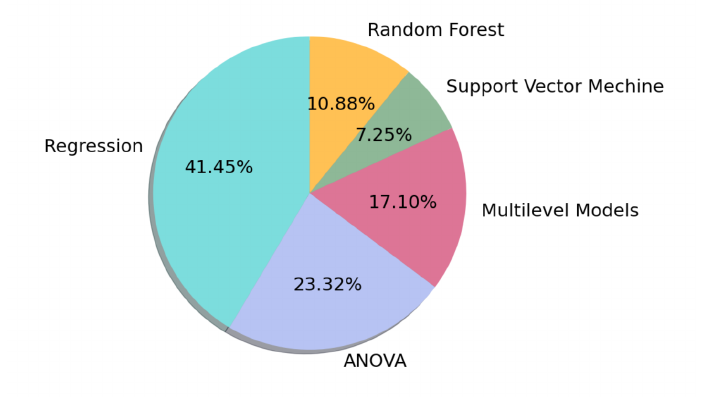
Figure 9. Analysis methods used in the primary